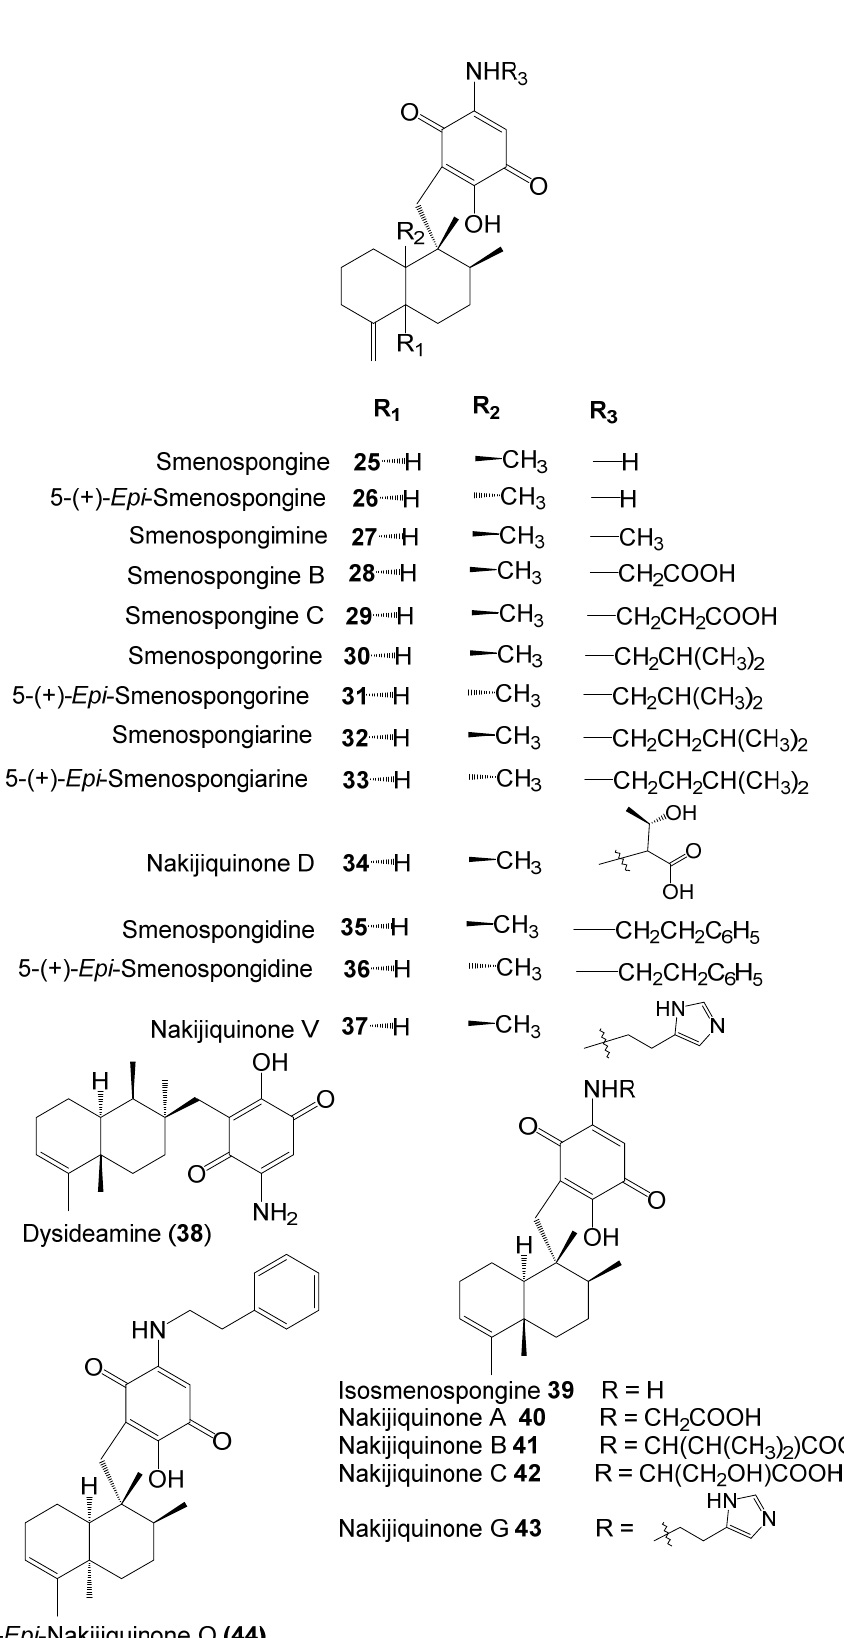
Figure 3. Chemical structures of compounds 25 – 44 .